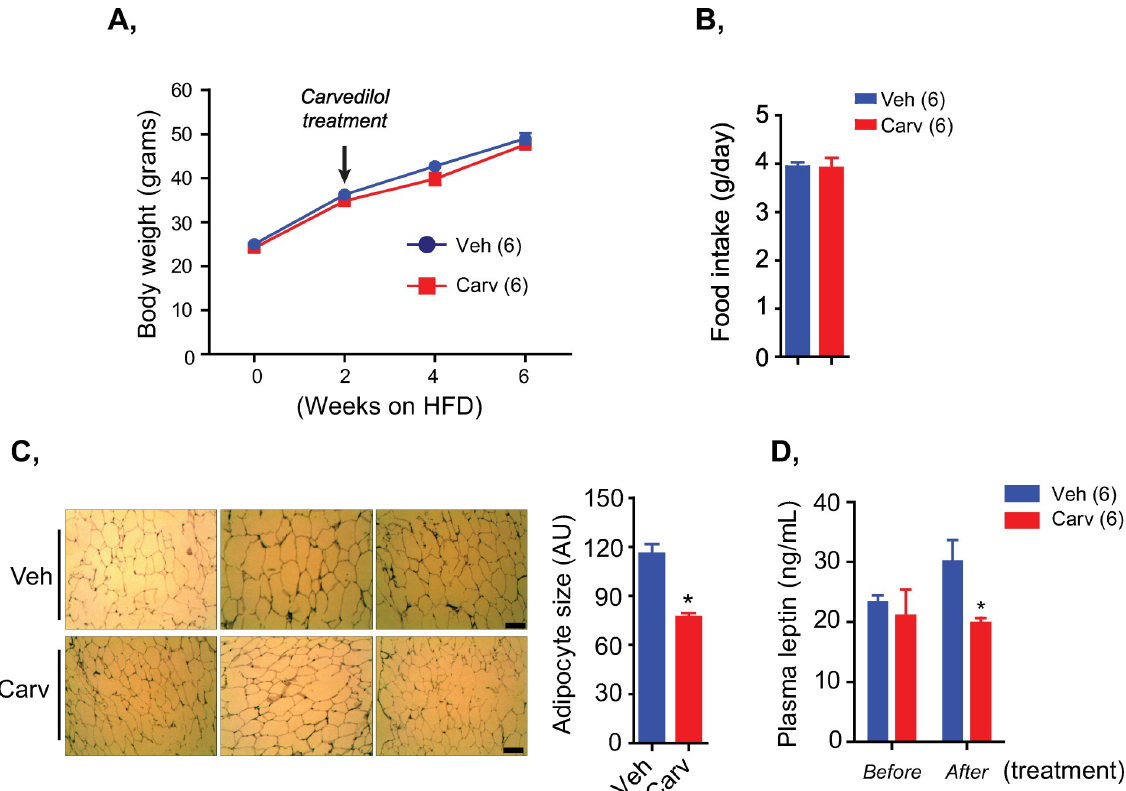
Fig 3. Carvedilol treatment in HFD-fed mice reduced white adipose tissue enlargement and plasma leptin without affecting food consumption and body weight. A, Body weight of HFD-fed mice treated with vehicle (veh) or carvedilol (carv). B, Total daily food intake of HFD-fed mice treated with vehicle (veh) or carvedilol (carv) measured in 3 consecutive days. C, Representative figures of H&E staining (left) and quantification of white adipocyte size (right) of HFD-fed mice treated with vehicle or carvedilol. Scale bar, 100 μ m. D, Plasma leptin levels of mice before and after carvedilol treatment. Data are presented as mean ± S.E.M. Student’s t-tests in bar graphs and two-way ANOVA in line graphs. Hormone measurement and histological analysis were performed in